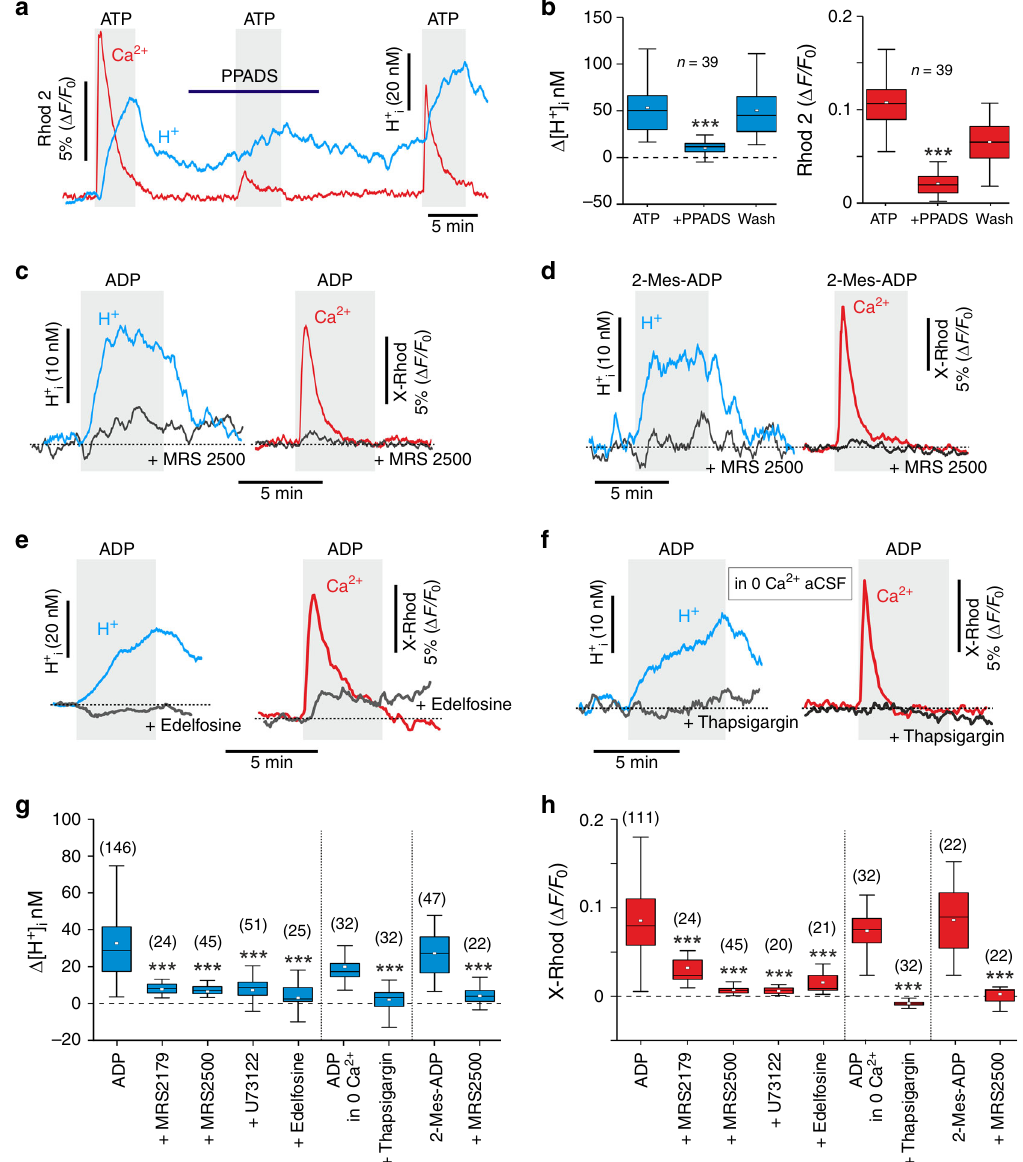
Fig. 6 Signalling mechanisms underlying purinergic modulation of bicarbonate transport in astrocytes. a Representative recording illustrating the effect of P2 receptor antagonist PPADS (100 µ M) on [H + ] i and [Ca 2 + ] i responses induced by ATP (1 mM) in astrocytes. Averaged traces of [H + ] i and [Ca 2 + ] i changes in ten astrocytes are shown. b Summary data illustrating the effects of PPADS on peak increases in [H + ] i and [Ca 2 + ] i induced by ATP in astrocytes. c Intracellular acidi fi cation and Ca 2 + responses in astrocytes induced by ADP (200 µ M) are blocked by P2Y 1 receptor antagonist MRS2500 (2 µ M). Averaged traces of ADP-induced [H + ] i and [Ca 2 + ] i responses in ten astrocytes are shown. d The effects of ATP/ADP on [H + ] i and [Ca 2 + ] i in astrocytes are mimicked by P2Y 1 receptor agonist 2-Mes-ADP (20 µ M). Averaged traces of 2-Mes-ADP-induced [H + ] i and [Ca 2 + ] i responses in the absence and presence of MRS2500 in 13 astrocytes are shown; e Intracellular acidi fi cation and [Ca 2 + ] i responses in astrocytes induced by ADP are blocked by phospholipase C inhibitor edelfosine (10 µ M). Averaged traces of ADP-induced [H + ] i and [Ca 2 + ] i responses in 11 astrocytes are shown. f Intracellular acidi fi cation and [Ca 2 + ] i responses in astrocytes induced by ADP are blocked after depletion of intracellular Ca 2 + stores with thapsigargin (1 µ M) in the absence of extracellular Ca 2 + . Averaged traces of ADP-induced [H + ] i and [Ca 2 + ] i responses in 16 astrocytes are shown. g , h Summary data illustrating the effects of P2Y 1 receptor blockade (MRS2179, 20 µ M; MRS2500, 2 µ M), phospholipase C inhibition (U73122, 10 µ M; edelfosine, 10 µ M), removal of extracellular Ca 2 + (0 Ca 2 + conditions) or removal of extracellular Ca 2 + combined with depletion of intracellular Ca 2 + stores with thapsigargin (1 µ M) on peak increases in [H + ] i and [Ca 2 + ] i induced by ADP (200 µ M) in astrocytes. Peak [H + ] i and [Ca 2 + ] i responses induced in astrocytes by 2-Mes- ADP (20 µ M) in the absence and presence of MRS2500 are also shown. In the box-and-whisker plots, the central dot indicates the mean, the central line indicates the median, the box limits indicate the upper and lower quartiles and the whiskers extend to 1.5 IQR from the quartiles. Numbers in parentheses indicate the numbers of individual astrocytes recorded in 3 – 5 separate cultures prepared from the same number of animals. *** denotes difference from the response recorded in control conditions with p < 0.001 (one-way ANOVA with Tukey ’ s post-hoc test). Source data are provided as a Source Data fi